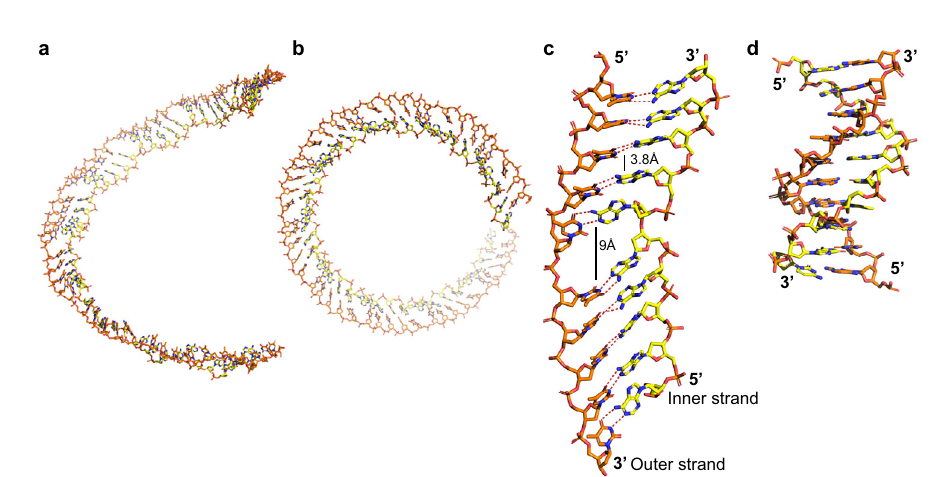
Fig. 5 | Extended and unwound conformation of the duplex intermediate. The inner strand isshown in yellow and the outerstrand orange. a View of 48bpof the duplexwiththe fi lamentaxisorientedvertically. b Top viewshowingthattheinner strandisalwaysclosertothe fi lamentaxisthantheouterstrand. c Close-upviewof a10bpsegmentfromthecentralportionofthe fi lament.Thebasepairsarespaced